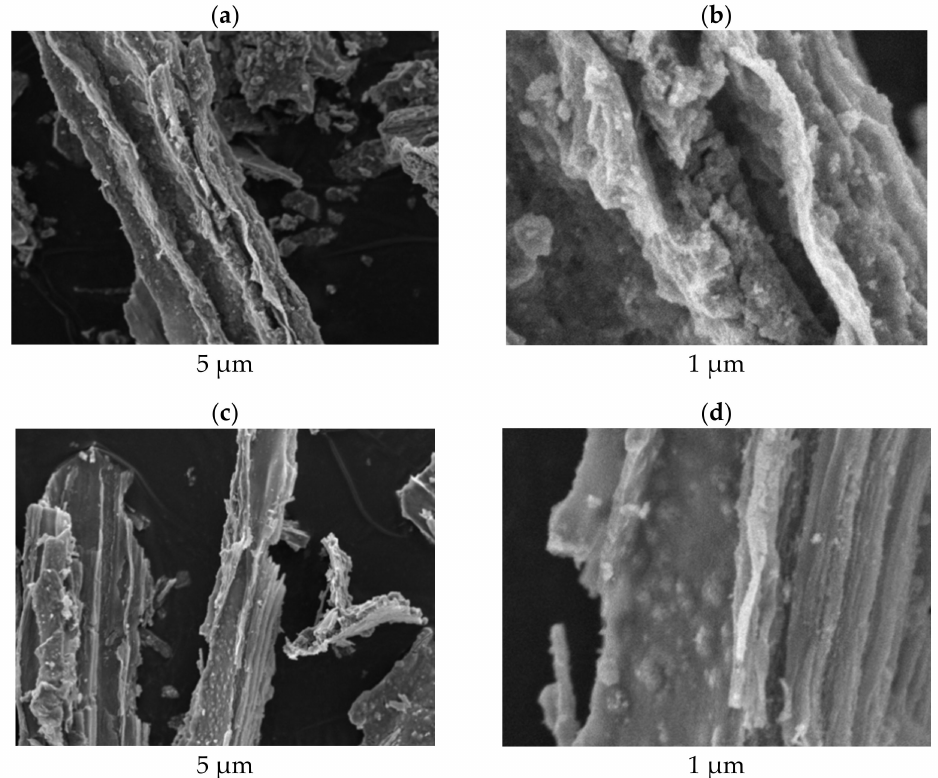
Figure 2. SEM images of fibrous TiO 2 –3% Ce ( a , b ) and TiO 2 –5% Ce ( c , d